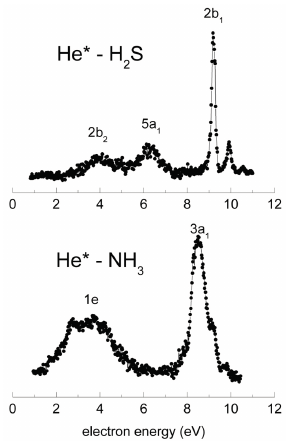
Figure 6. The obtained PIES spectra in Penning ionization studies of hydrogen sulfide (upper panel) and ammonia (lower panel) molecules by using He * ( 3 S 1 , 1 S 0 ,) metastable atoms. In the 2b 1 band of the He * –H 2 S spectrum, the two peaks recorded at an electron energy value of 9.18 and 9.94 eV, and related to He * ( 3 S 1 ) and He * ( 1 S 0 ) collisional ionization events, respectively, appear well separated (see upper panel). The two He * ( 3 S 1 , 1 S 0 ,) metastable components are still present, even if less separated, in the wide 3a 1 band of the He * -NH 3 spectrum (see lower